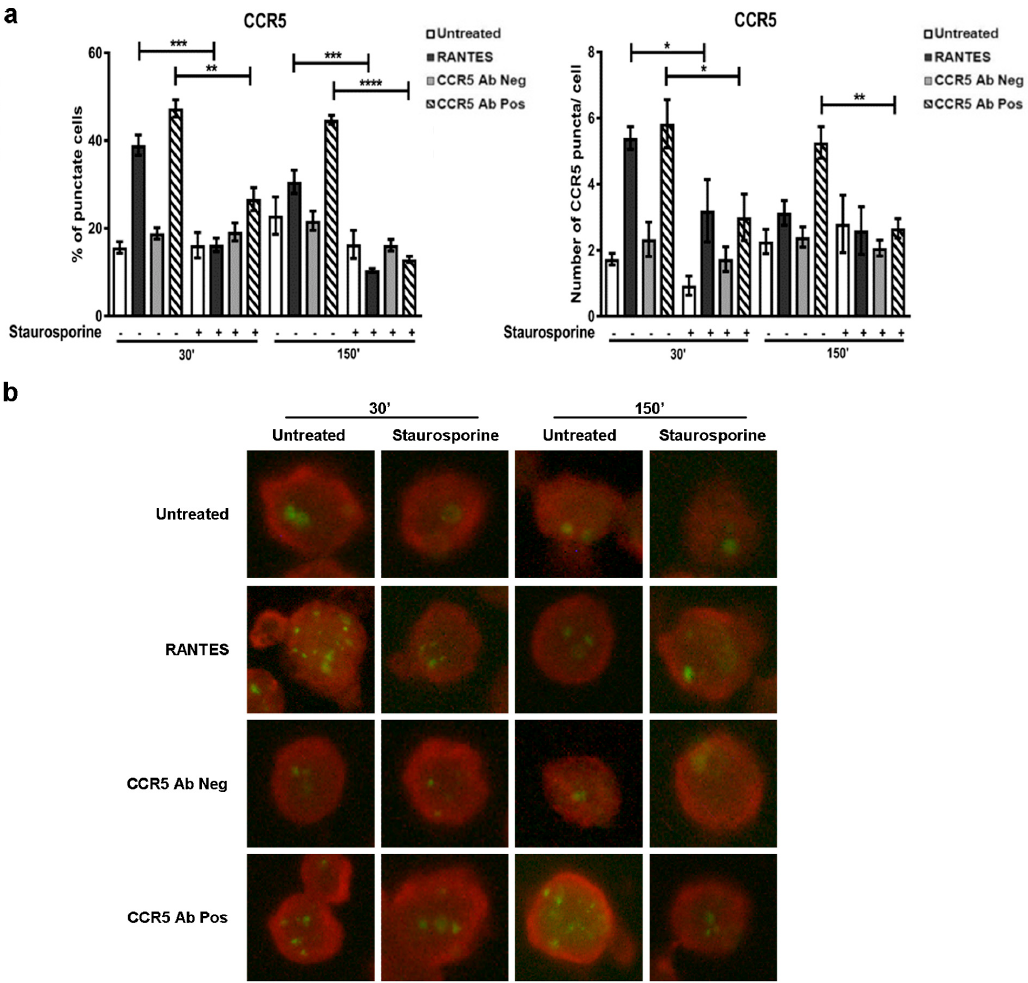
Figure 1. CCR5 internalization in the presence of a pan-kinase inhibitor (staurosporine). After 1 h of pre-treated with staurosporine (50 nM), R5-SupT1-L23 cells were stimulated, or not, with CCR5 Ab Pos, RANTES (positive control) and CCR5 Ab Neg (negative control). The cells were harvested at 30 min and at 150 min (30 min incubation, wash, additional 120 min incubation in medium without stimuli). ( a ) The percentage of cells with the punctate form of CCR5 (left) and the number of CCR5 puncta per cell (right) in cells treated or not with the stimuli, with or without staurosporine treatment, stained with anti-CKR5(D6), are stated. Data are representative of three independent experiments. Bar graphs represented mean ± standard deviation (SD) of three independent experiments. Student’s t -test was performed and p -values are shown. * p ≤ 0.05, ** p ≤ 0.01, *** p ≤ 0.001, **** p ≤ 0.0001; ( b ) a representative immunofluorescence image of cells positive for CCR5 detection (lens magnification: 63×). Evans Blue dye was used as a counter stain.